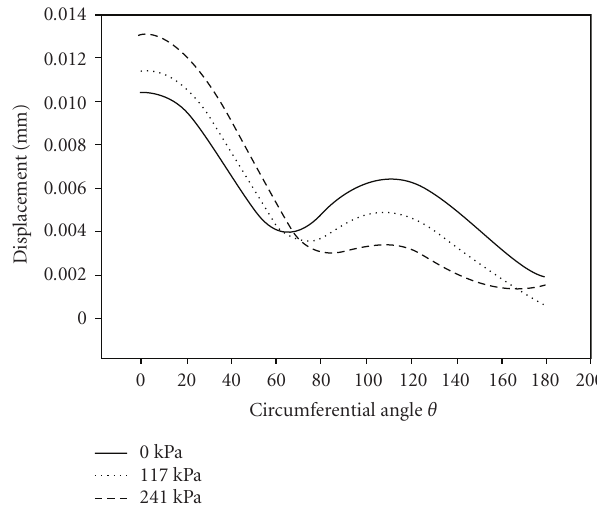
Figure 8: The magnitude of the displacement vector on the disk hat near the bolt circle as a function of circumferential angle for inflation pressure of 0 kPa, 117 kPa, and 241